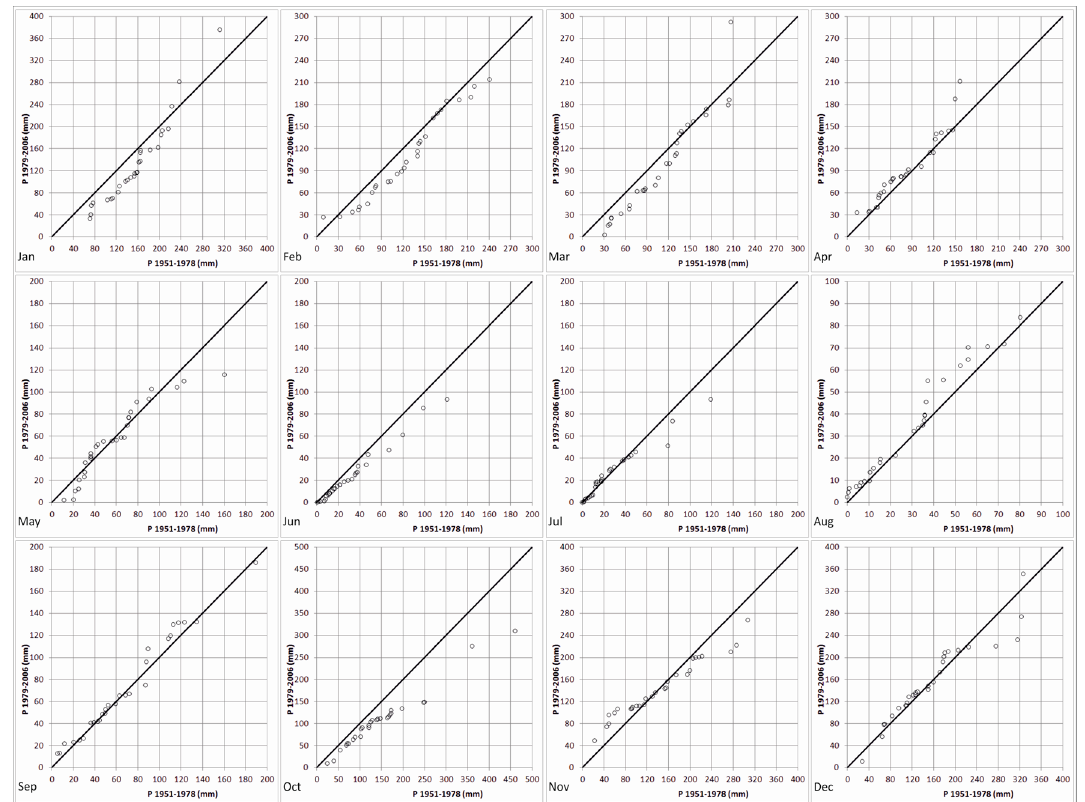
Figure 6. Results of the ITA method for the Rainfall Zone T2 for the period